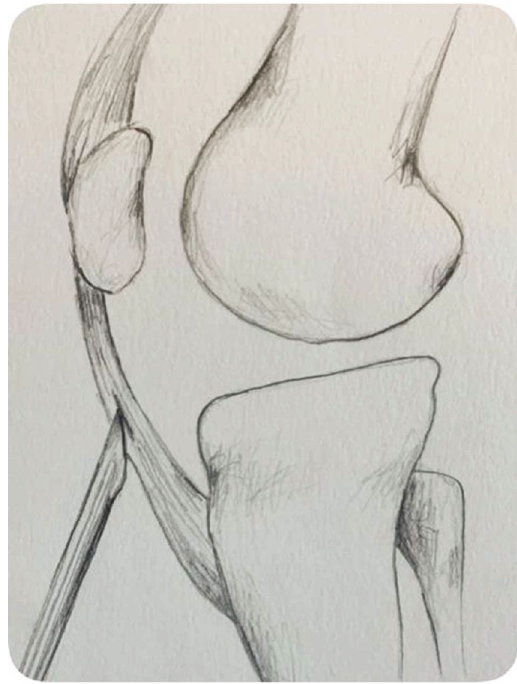
Figure 7: Illustration of overall mesh fi xation construct through the patellar tendon distally and around medial and lateral sides of patella with fi xation into proximal quadriceps tendon.